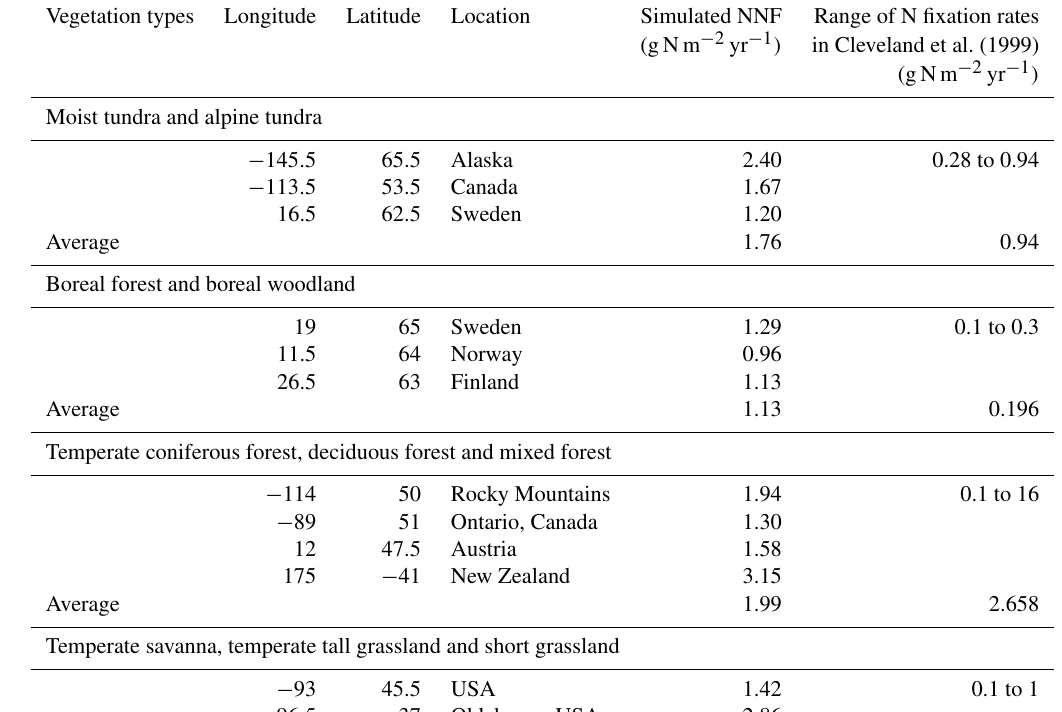
Table 3. Site-by-site comparison of modelled NNF (steady-state run, 340ppm CO 2 , with e = 0 . 175) with biological N fixation data summa- rized in Cleveland et al.